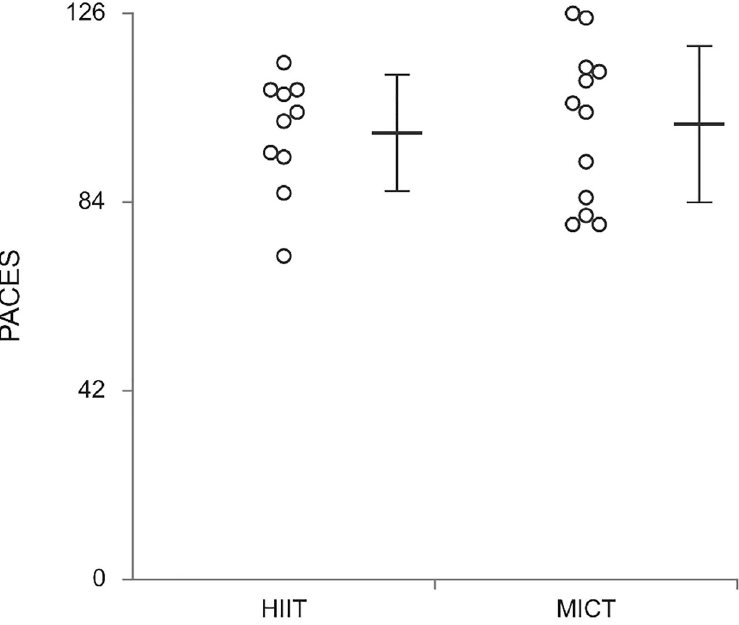
Fig 4. Dot plot of individual exercise enjoyment scores (PACES) and mean ( ± SD) PACES score post 12 weeks of training for both HIIT and MICT.